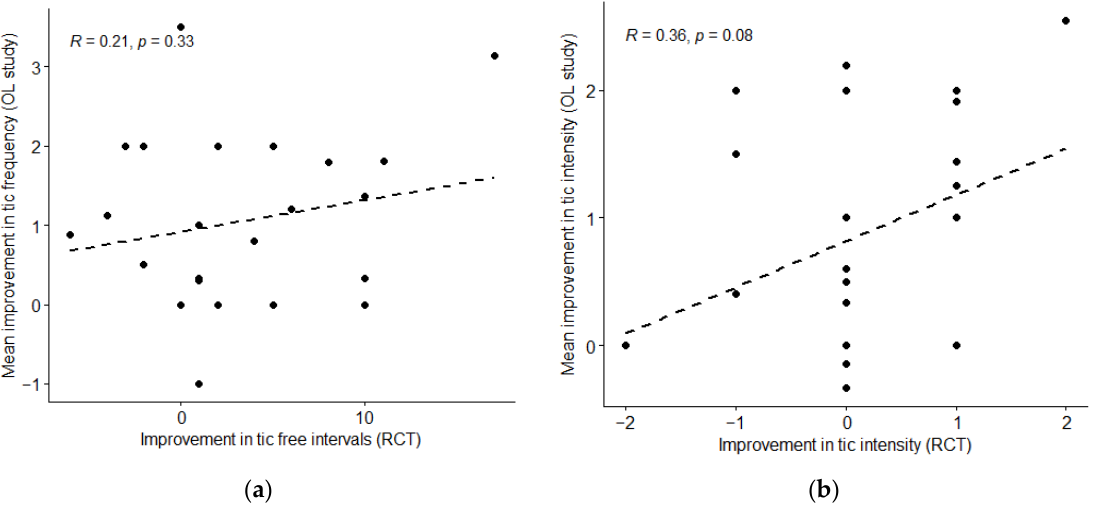
Figure 5. ( a ) Each participant’s mean improvement in tic frequency following stimulation sessions during this open ‐ label study was compared with his or her improvement in tic frequency (number of 10 ‐ s tic ‐ free intervals) in the first 5 ‐ minute block of rhythmic stimulation in the RCT (n = 24). ( b ) Each participant’s mean improvement in tic intensity following stimulation sessions during open ‐ label study was compared with his or her improvement in tic intensity in the first 5 ‐ minute block of rhythmic stimulation in the RCT (n = 25).